Question: What type of chart is this?
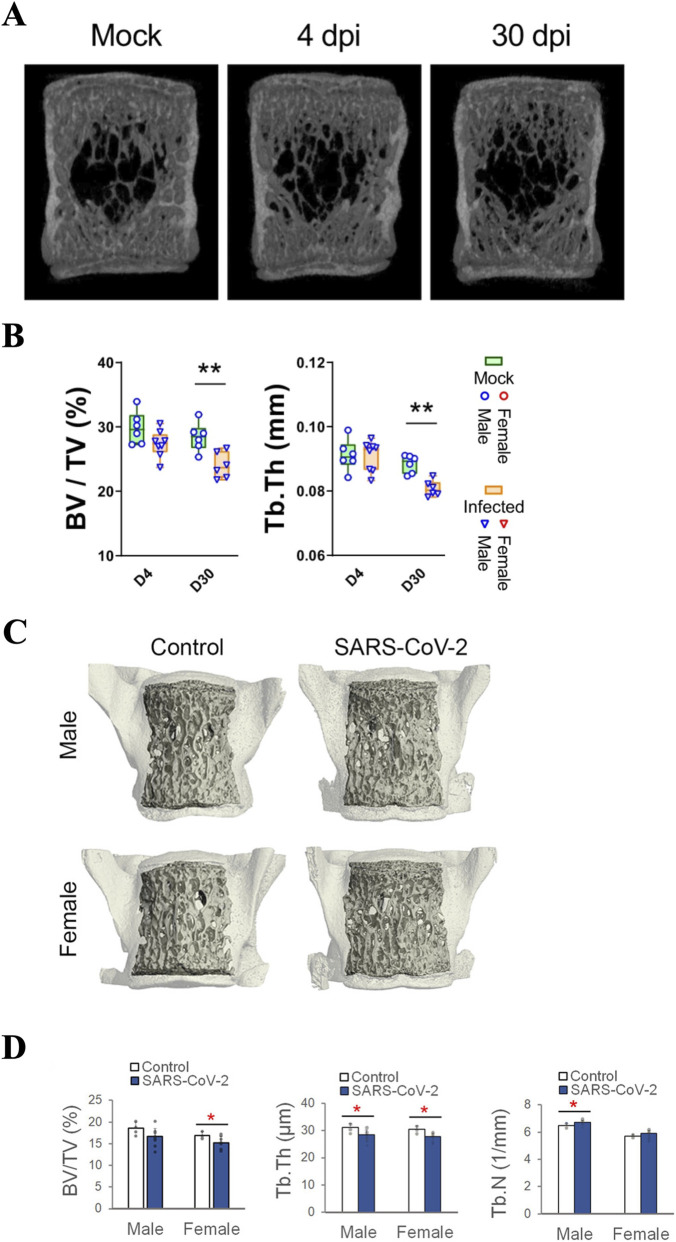
Answer: bar